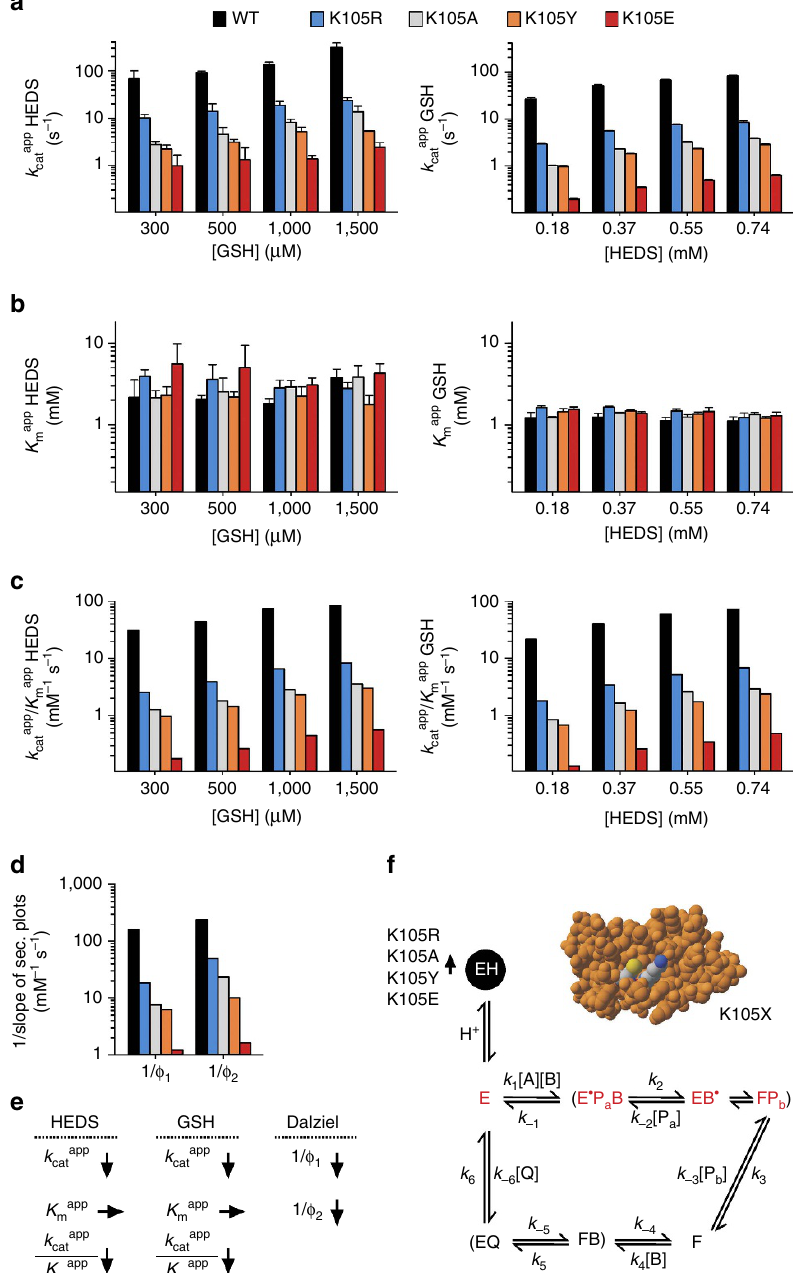
Figure 3 | Replacement of Lys105 slows down the turnover of both substrates in the HEDS assay. ( a , b ) Selected k cat app and K m app values of ScGrx7 wild- type enzyme and K105X mutants for HEDS and GSH. ( c ) Calculated catalytic efficiencies from a and b . ( d ) Reciprocal Dalziel coefficients obtained from Supplementary Fig. 5. ( e ) Summary of the altered kinetic parameters. ( f ) Data interpretation based on a proposed catalytic mechanism with HEDS and GSH as true substrates 18 . The altered concentration of the inactive protonated enzyme ‘EH’ upon mutation of Lys105 is highlighted. Kinetically relevant enzyme species are labelled in red and comprise the active free enzyme ‘E’ (thiolate form), a mixed disulfide between the enzyme and 2-mercaptoethanol ‘E (cid:3) ’ and glutathionylated enzyme ‘F’. HEDS and GSH correspond to substrates A and B, respectively. GSSEtOH is the intermediate product and substrate ‘B (cid:3) ’. Two molecules of 2-ME and GSSG correspond to products P a,b and Q, respectively. Original plots and kinetic parameters for a – c are shown in Supplementary Fig. 4 and Supplementary Table 3 and are the mean ± s.d. from at least three independent replicates. Statistical analyses and P -values for the k cat app and K m app values from a and b are listed in Supplementary Table 11. Reciprocal Dalziel coefficients for d and true k cat values are listed in Supplementary Table glutathione-scaffold model. The impaired interaction decelerated ( k ox app E 1/ F 1 4 1/ F 2 E k red app ) and explains the rather minor the oxidative half-reaction and decreased the steady-state effects of the Glu170 replacements as compared with the K105X concentration of available glutathionylated enzyme for the rate- mutants. In summary, steady-state kinetics for E170A/K revealed limiting turnover of GSH. an impaired GSSCys interaction in accordance with the